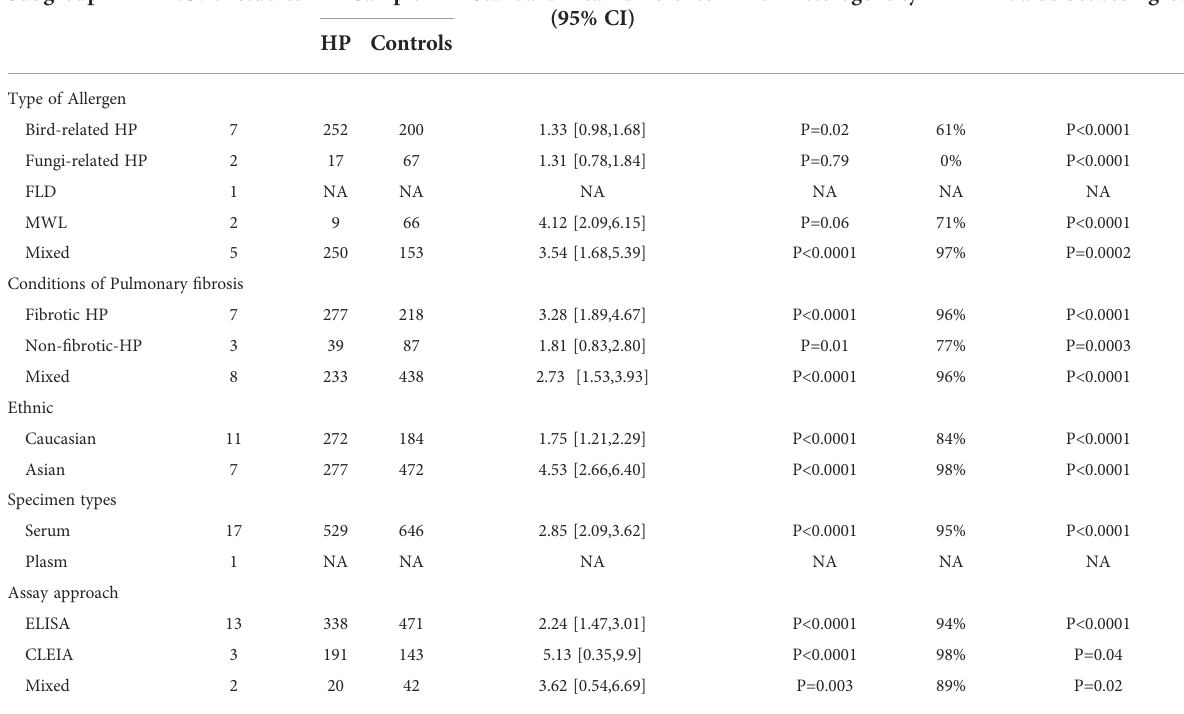
TABLE 3 Subgroup analyses of the association between KL-6 and HP in this meta-analysis. Subgroup NO. of studies Sample Standard mean difference P for Heterogeneity I 2 P Value between groups (95% CI) HP